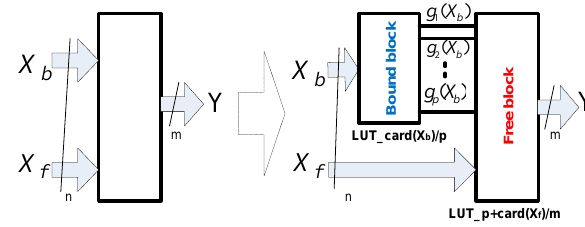
Figure 2. The idea of serial decomposition.